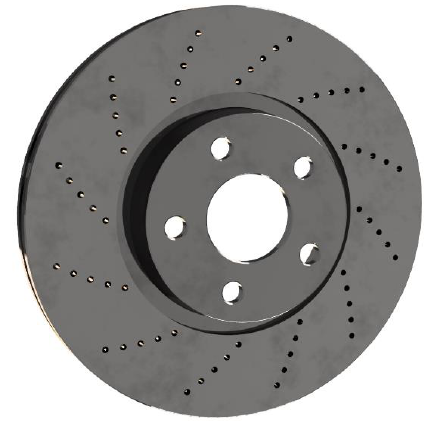
Fig. 1. Ventilated and drilled brake disc Brake discs are elements that wear out during operation and must be replaced if their dimensions exceed the limits. Cracks running across the entire width of the friction sur- face are also unacceptable. The most common causes